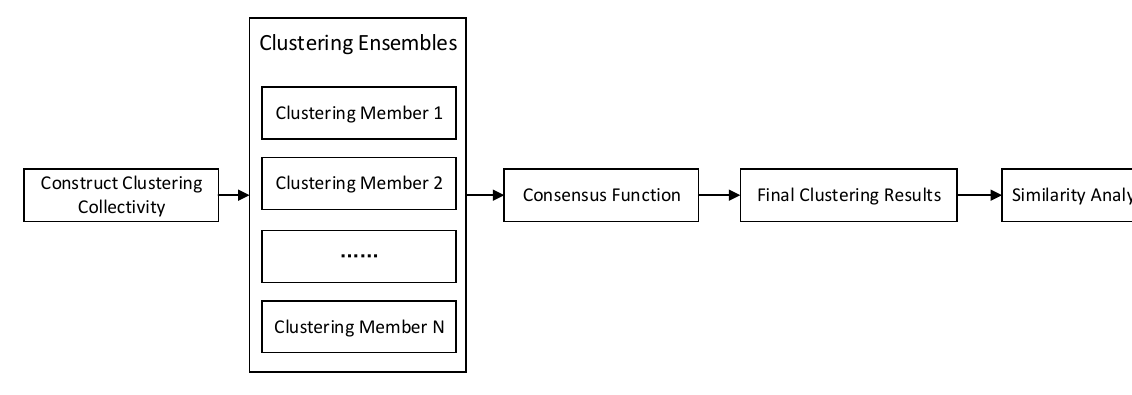
Figure 1. Clustering Ensemble Processes.